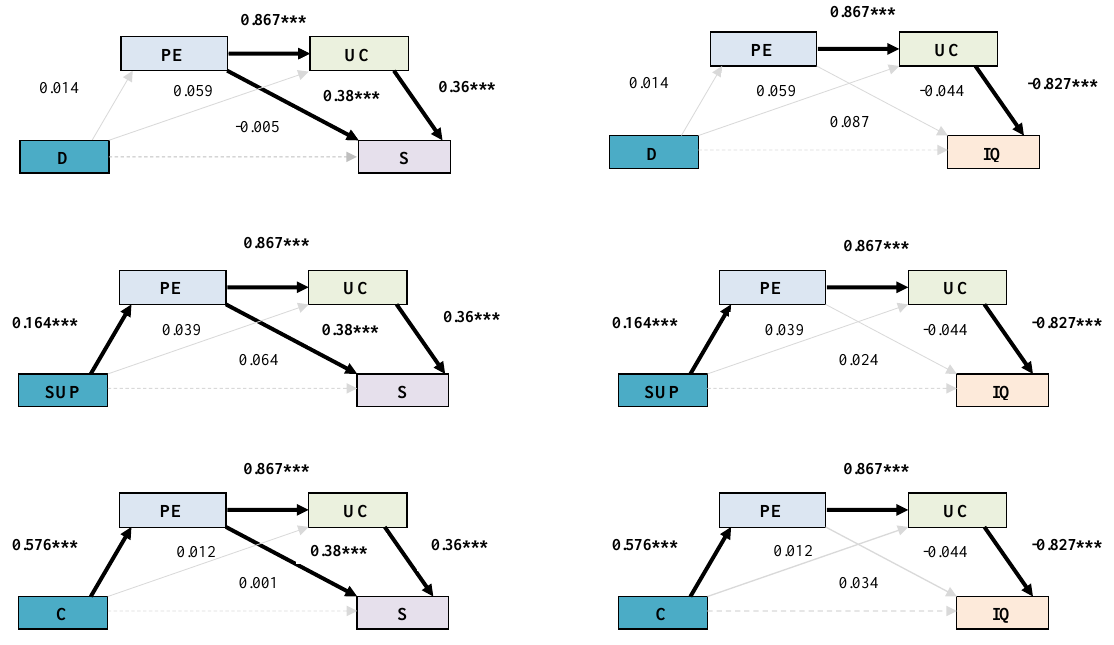
Figure 2. Final model. Nonstandardized B Coefficients and statistical significance. *** p < 0.001.